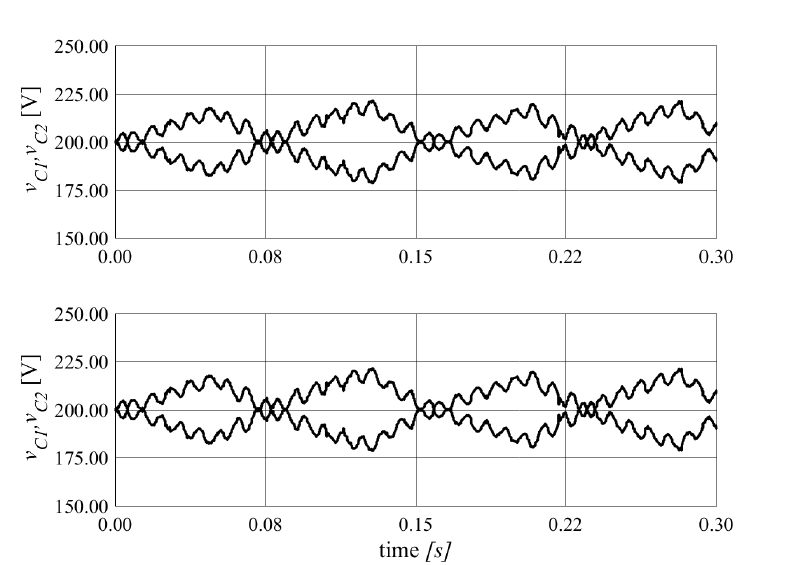
Figure 17. Experimental result: capacitors voltages for the traditional SVM (upper trace) and proposed one (lower trace), when m = 0.94, v ∗